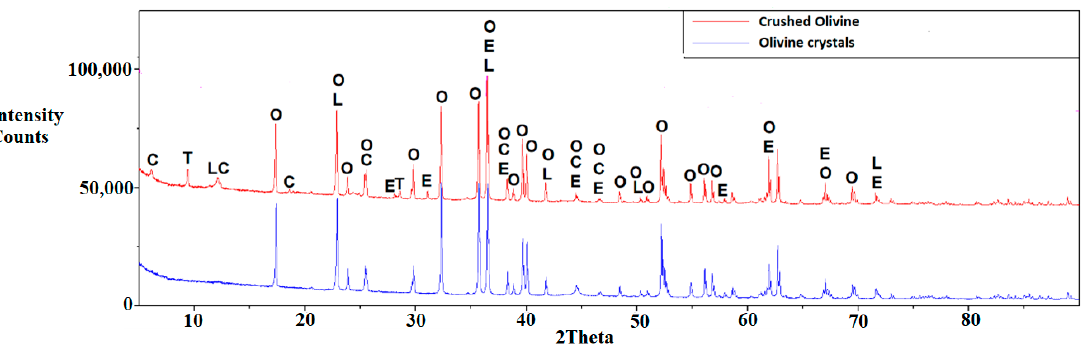
Figure 6. XRD patterns for crushed olivine (top) and olivine crystals (bottom). O = Olivine, C = Clinochlore, E = Enstatite, L = Lizardite, T = Talc. For crushed olivine, the phases identified are olivine, clinochlore, enstatite, lizardite, and talc. For olivine crystals, the phase identified is olivine.